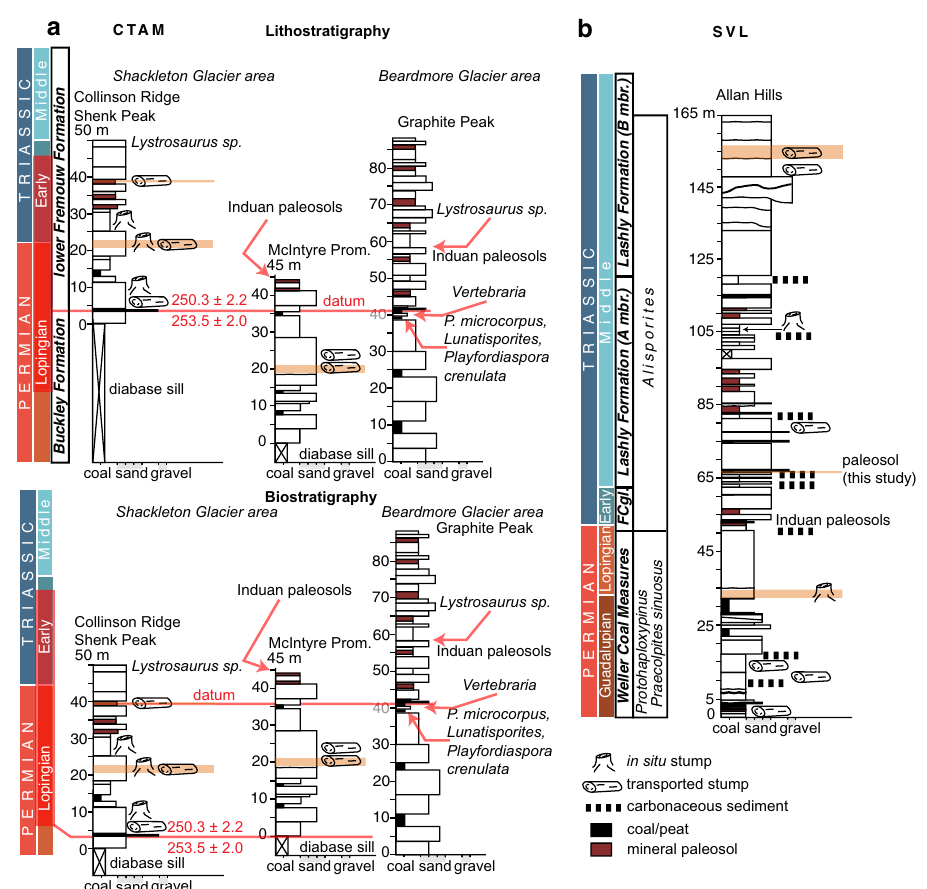
Figure 2. Stratigraphy of the study area. ( a ) Permian and Triassic stratigraphy of the central Transantarctic Mountains (CTAM). Measured sections from Collinson Ridge, McIntyre Promontory, and Graphite Peak are displayed in two configurations. The lithostratigraphy configuration places a datum at the contact between the Buckley and Fremouw formations. The available maximum depositional ages 21 for these strata are indicated and are derived from Collinson Ridge and Layman Peak. The orange highlighted areas denote the fossil wood used in this study. Palynology 20 is shown for Graphite Peak as it produces regionally significant pollen near the lithostratigraphic contact. The biostratigraphy configuration places the datum at the last appearance of coal or glossopterid megafossils. The red bar on the timescale refers to the ranges of the maximum depositional ages plus their uncertainties. ( b ) Permian and Triassic stratigraphy for southern Victoria Land (SVL), Allan Hills (after 17 ). FCgl. refers to the Feather Conglomerate. The available palynology is indicated next to the timescale. The lowest most Triassic paleosol indicative of plant productivity used in this study is indicated along with stratigraphic positions of fossil wood used in this study. Figure created using Adobe Illustrator, v. 25.0.1, adobe.